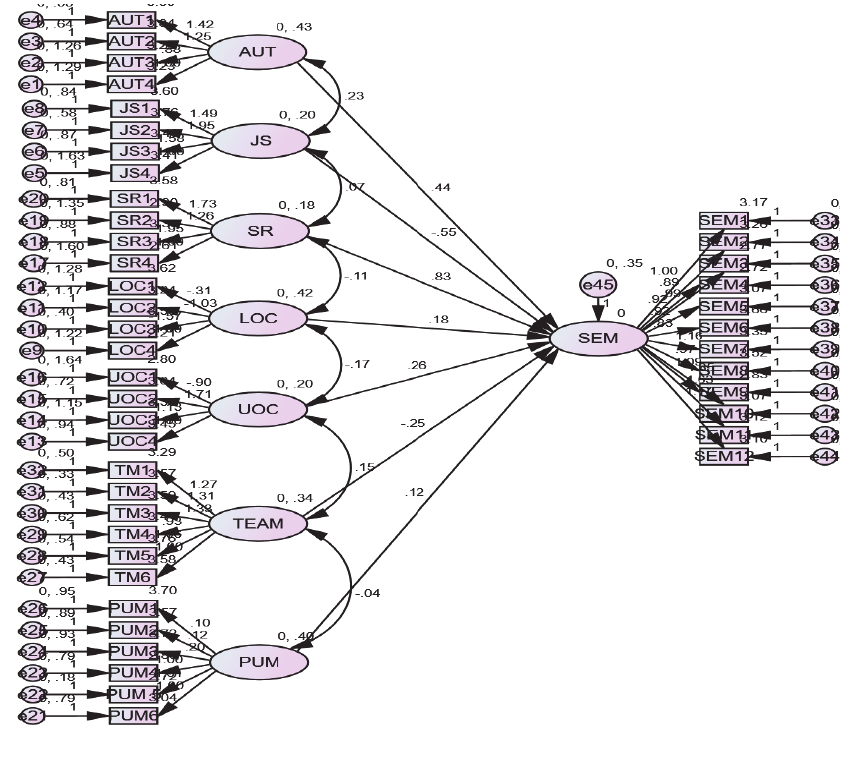
Fig. 3. Structural